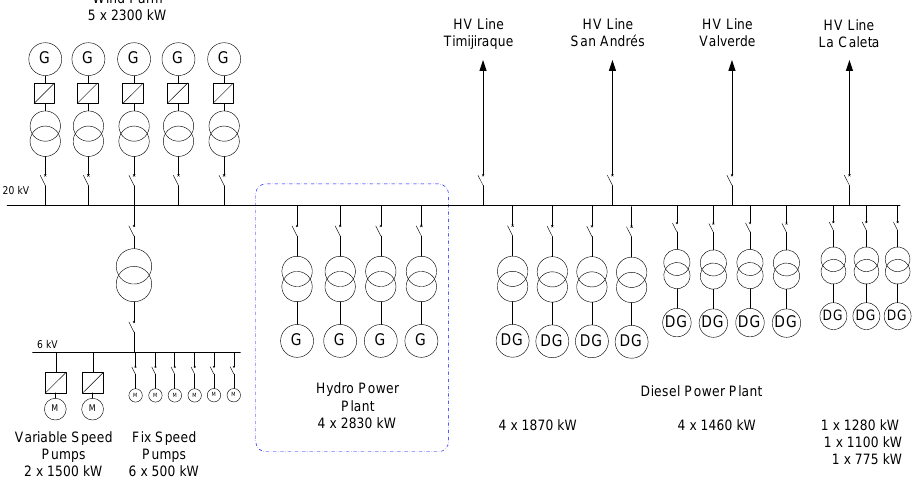
Figure 2. El Hierro power system, simplified one-line diagram.